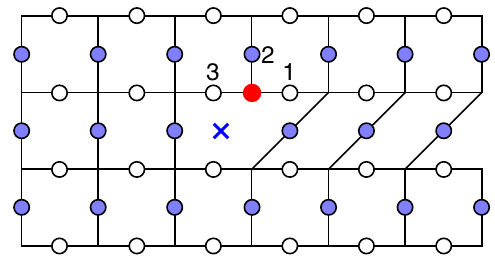
FIG. 9. An ˆ x dislocation in the toric code model. When the unconventional Z 2 × Z 2 symmetry is imposed, the coefficient of the vertex term σ x 1 σ x 2 σ x 3 must be set to zero to respect the Z symmetry. This results in a degeneracy between topological charge values of the translational symmetry defect that differ by b ð T ; Z Þ ¼ e x